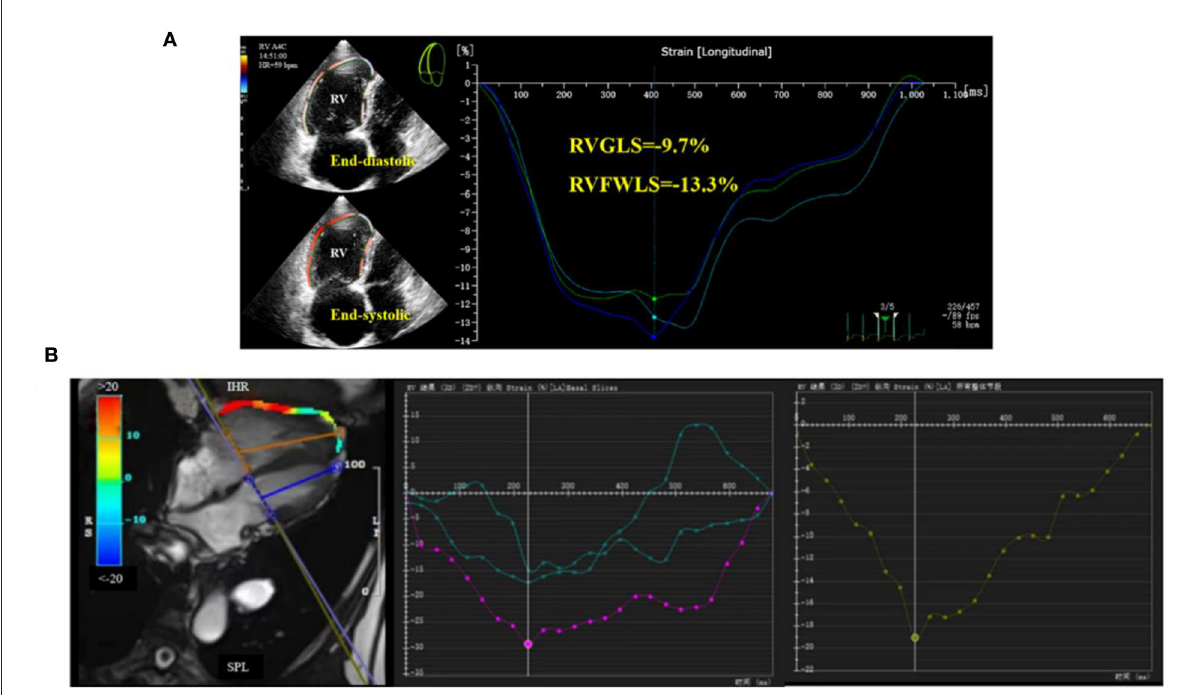
FIGURE1 Right ventricular global longitudinal strain (RVGLS) determination in CTEPH patients. (A) 2D-STE for measurement of RVGLS, and (B) CMR-FT for measurement of RVGLS.